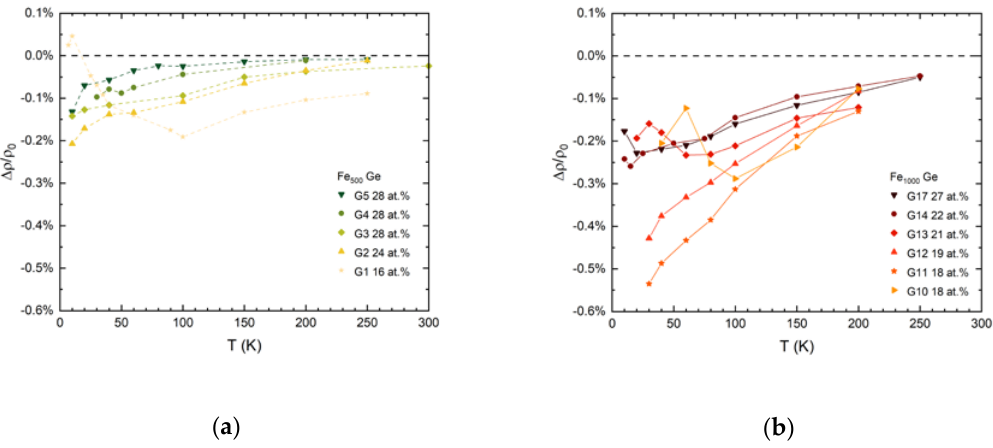
Figure 5. Low-field magnetoresistance vs. temperature of ( a ) Fe 500 -Ge and ( b ) Fe 1000 -Ge nanocomposite samples.